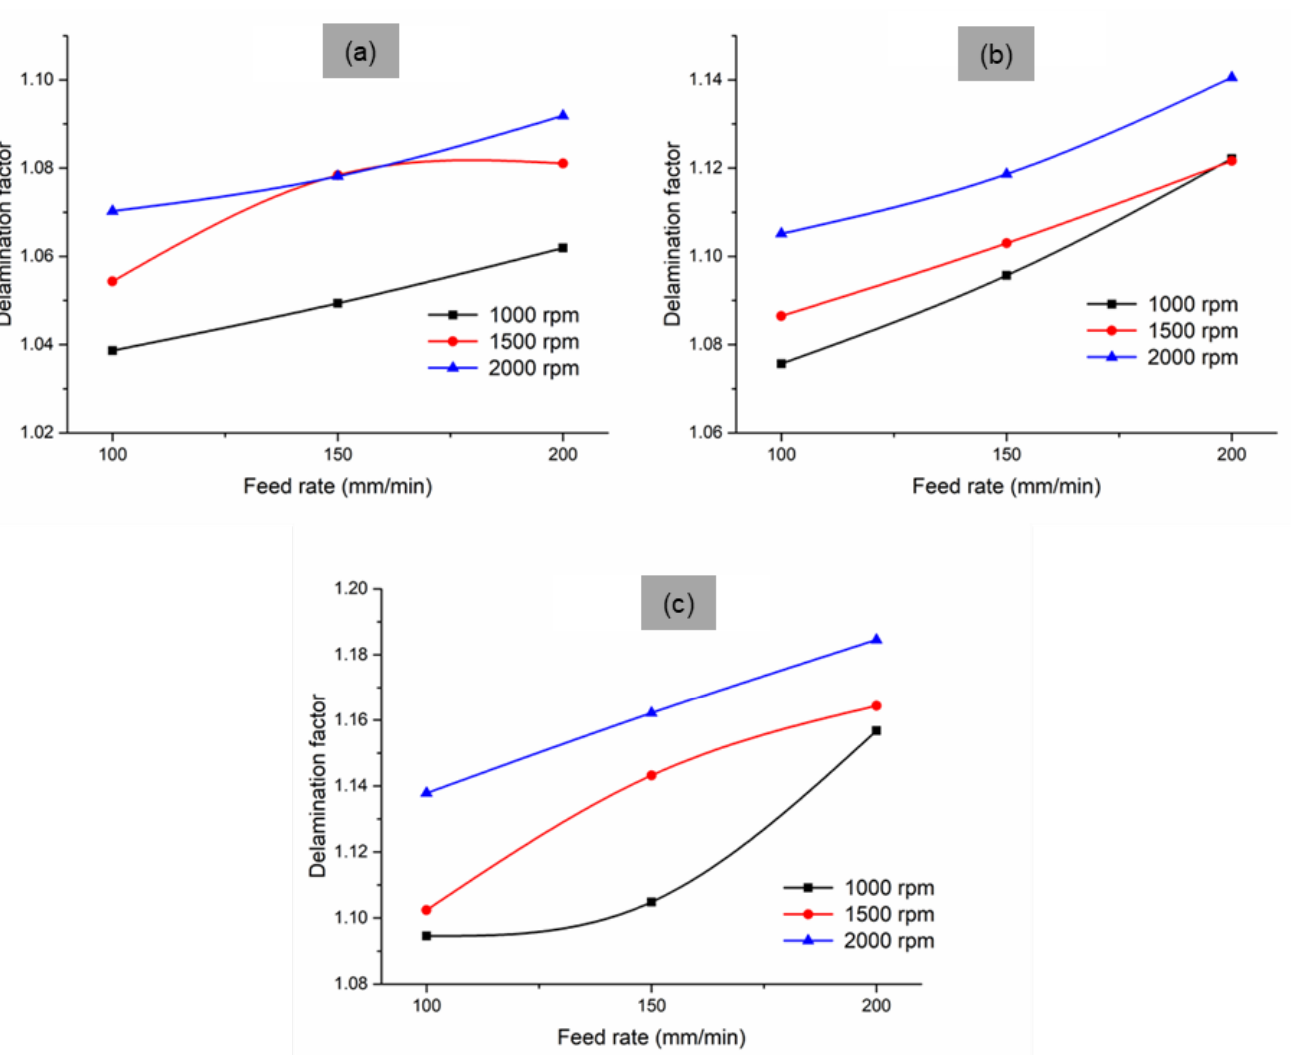
Figure 5. Variation in delamination factor on redmud-filled sisal composite structures at different point angles: ( a ) 90°, ( b ) 118°, and ( c ) 135°.